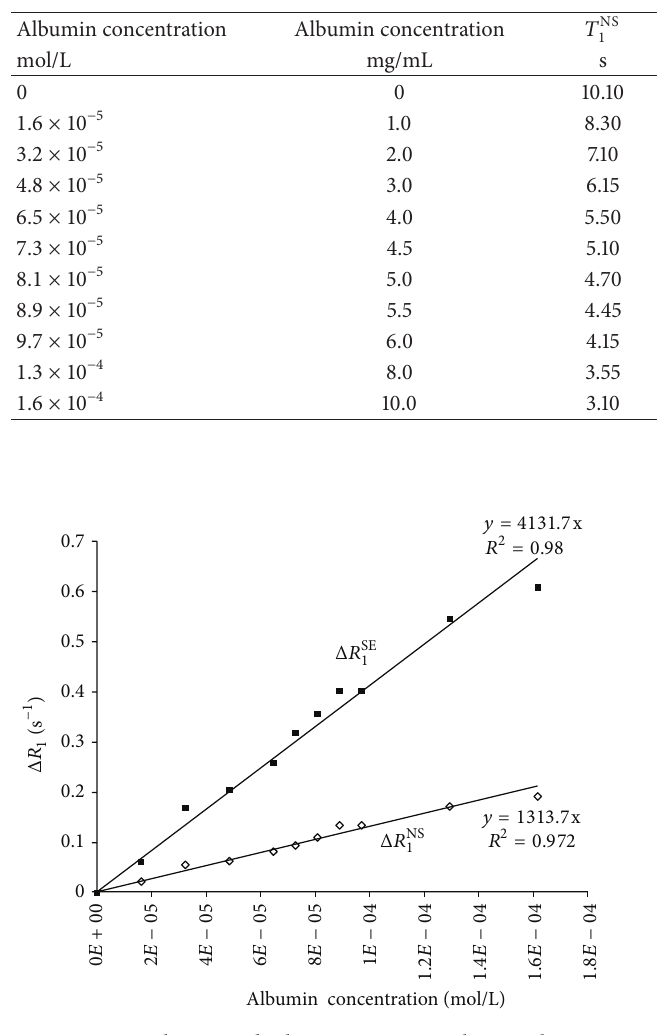
Figure 3: Nonselective and selective proton spin-lattice relaxation rates Δ𝑅 SE 1 and Δ𝑅 NS 1 as a function of the human albumin concen- tration.